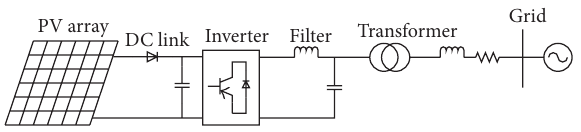
Figure 1: Schematic diagram of a grid-connected PV system.